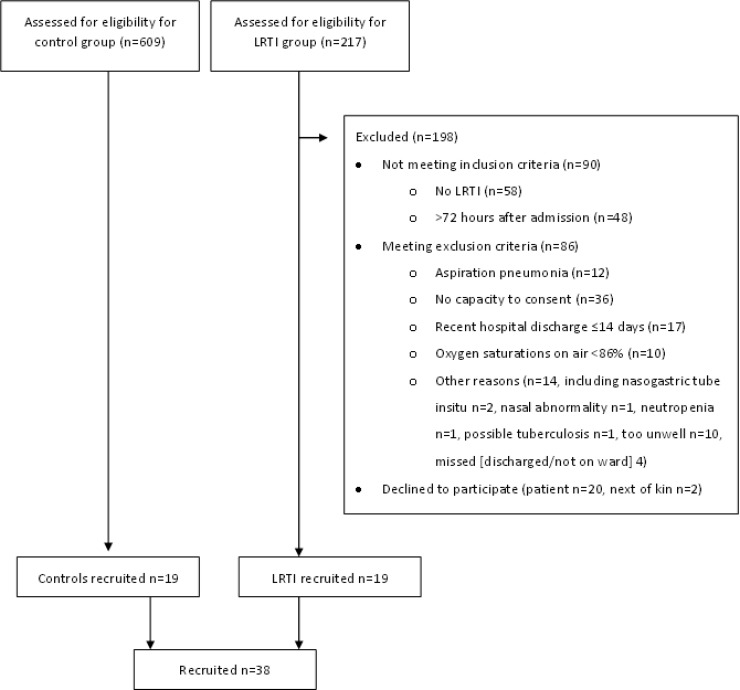
Screening and recruitment flowchart. Reasons for nonrecruitment for lower respiratory tract infection (LRTI) patients are detailed. The total number of patients screened was 826. Note that multiple reasons for nonrecruitment per patient were possible.